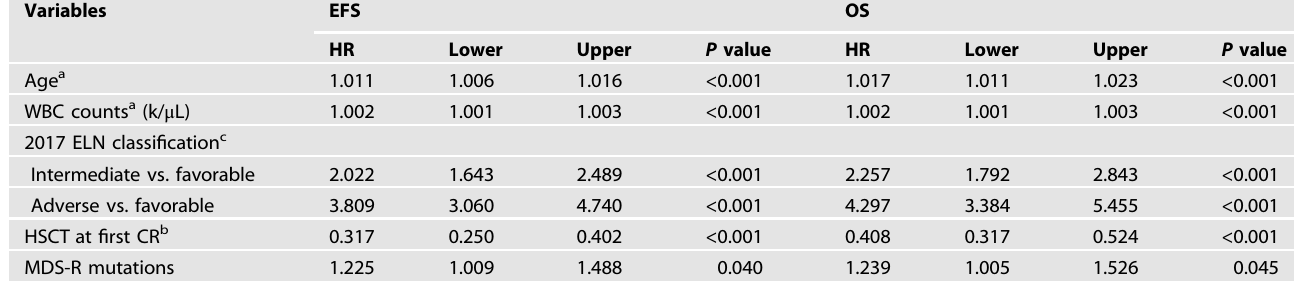
Table 3. Multivariate Cox proportional hazards regression